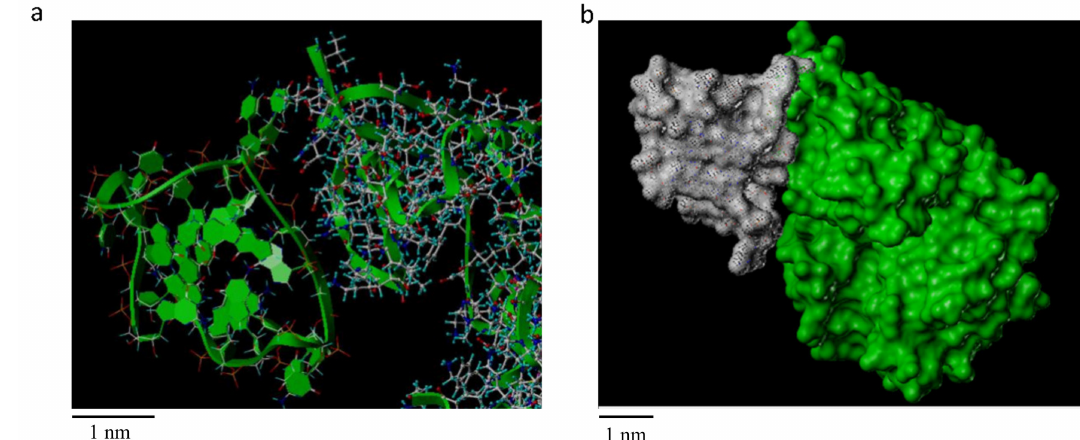
Figure 3. Computer simulation result of miR-1587 G-quadruplex and CASK docking in ( a ) ribbon pattern ( b ) surface pattern. As shown in ( a ), the G-quadruplex structure (left part, green) could bind to the CASK side of the α -helix and β -sheet, and ( b ) shows the G-quadruplex formed by miR-1587 had a surface similarity to CASK, possibly through multiple positions of